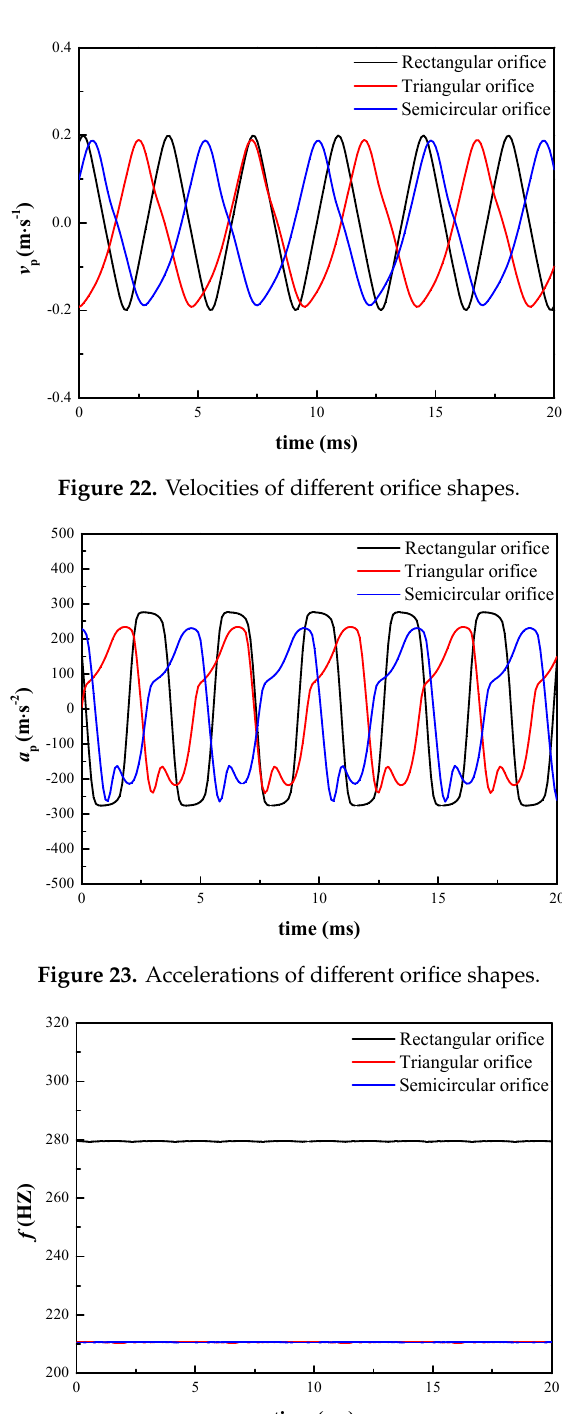
Figure 21. Displacements of different orifice shapes.